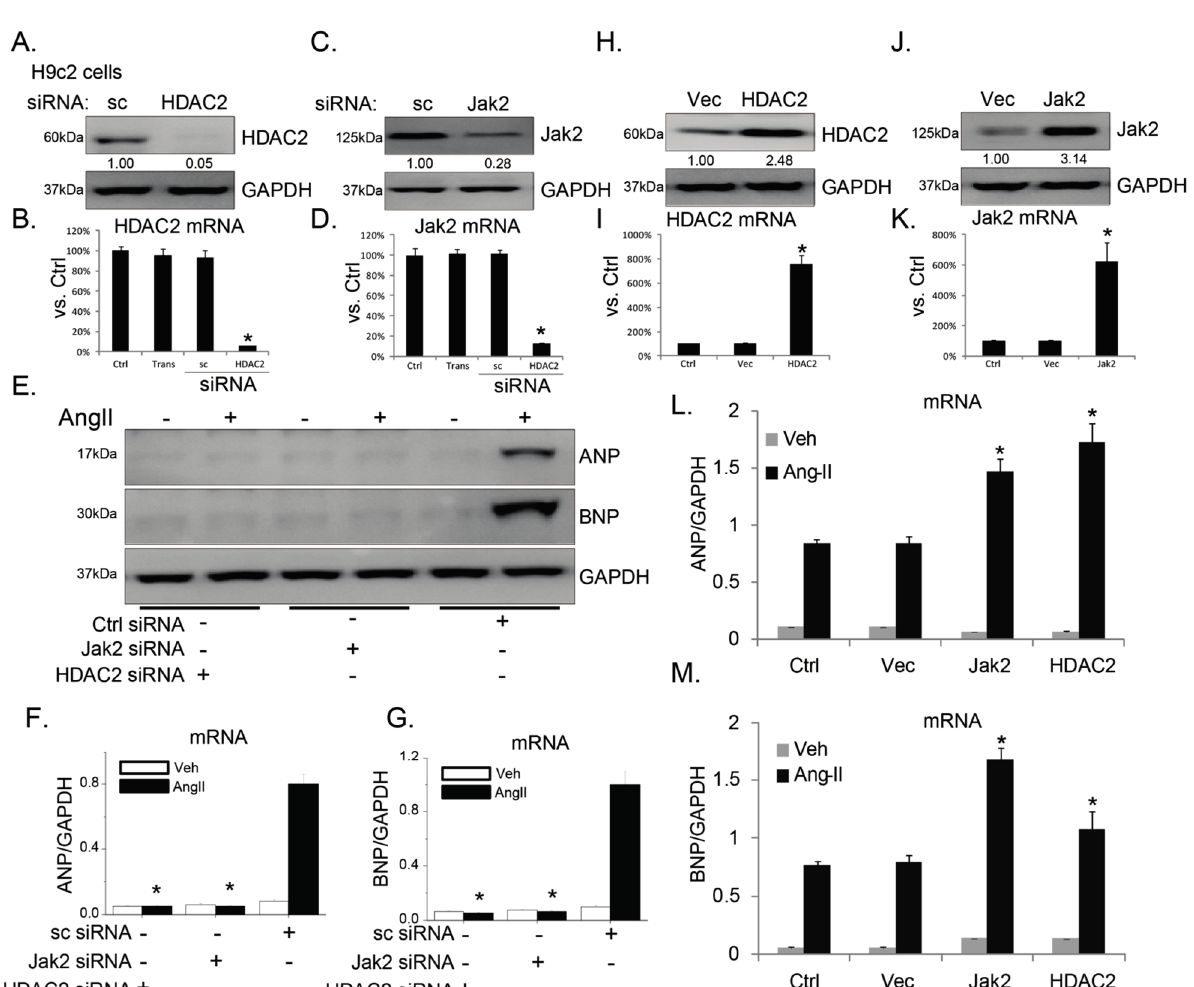
Figure 1. Janus kinase 2 (Jak2) and histone deacetylase 2 (HDAC2) are important for angiotensin II (Ang-II)-induced atrial natriuretic peptide ( ANP )/brain natriuretic peptide ( BNP ) expression in H9c2 cardiomyocytes. Protein and mRNA expression of HDAC2 ( A , B ) or Jak2 ( C , D ) in H9c2 cells transfected with scramble siRNA (sc-siRNA) or indicated siRNA (100 nM each, 48 h); Protein ( E ) and mRNA ( F , G ) expression of ANP , BNP and glyceraldehyde-3-phosphate dehydrogenase ( GAPDH ) before and after Ang-II (1 μ M, 24 h) treatment in H9c2 cells transfected with indicated siRNA; Protein ( H ) and mRNA expression of HDAC2 ( H , I ) and Jak2 ( J , K ) in stable H9c2 cells transfected with vector (“Vec”) or indicated cDNA plasmid (0.5 μ g/mL each); Message RNA (mRNA) expression of ANP ( L ) and BNP ( M ) before and after Ang-II (1 μ M, 24 h) treatment in stable H9c2 cells transfected with Jak2/HDAC2 plasmid or empty vector (“Vec”, 0.5 μ g/mL each). For all the mRNA assays, n = 6. Experiments in this figure were repeated three times with similar results obtained. All data were expressed as means ± SEM, GAPDH was tested as an internal control. * p < 0.05 vs. “Ctrl” group ( B , D , I , K ); * p < 0.05 vs. Ang-II group of sc-siRNA transfected or non-transfected H9c2 cells ( F , G , L , M ). “Trans” stands for transfection reagent only. “Veh” stands for fetal bovine serum